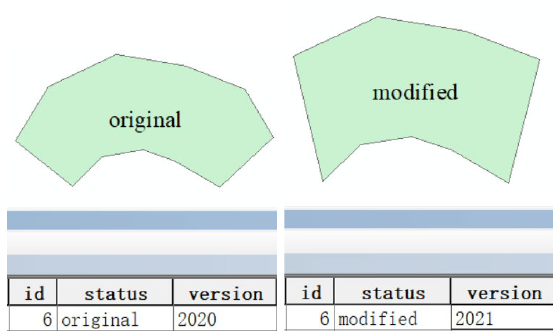
Figure 3 . Database fields information of modified features